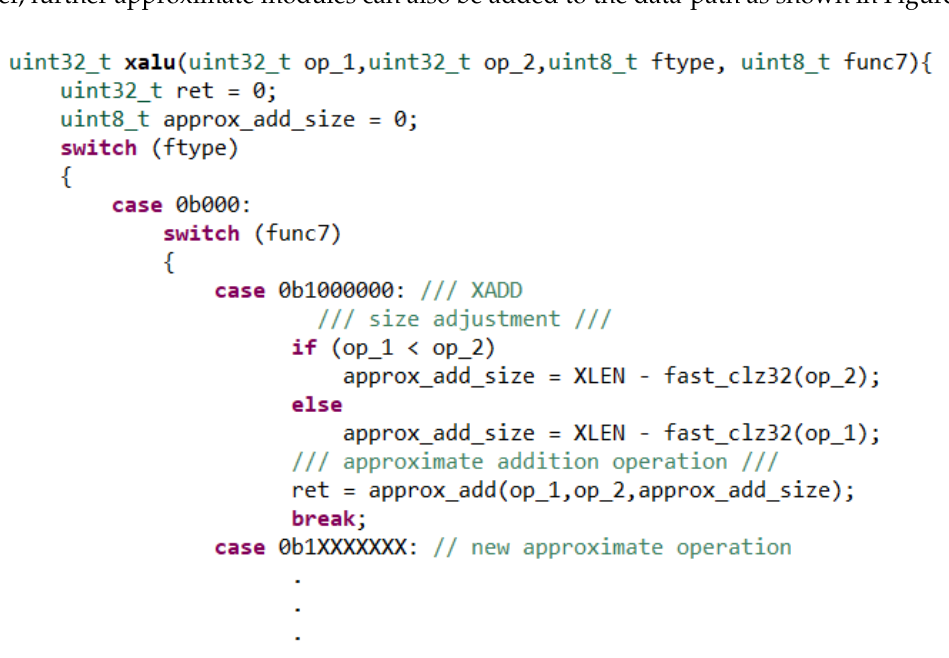
Figure 5. C code for XALU block in HLS. op_1 and op_2 refer to two operands and XLEN is the length of a register which is 32.